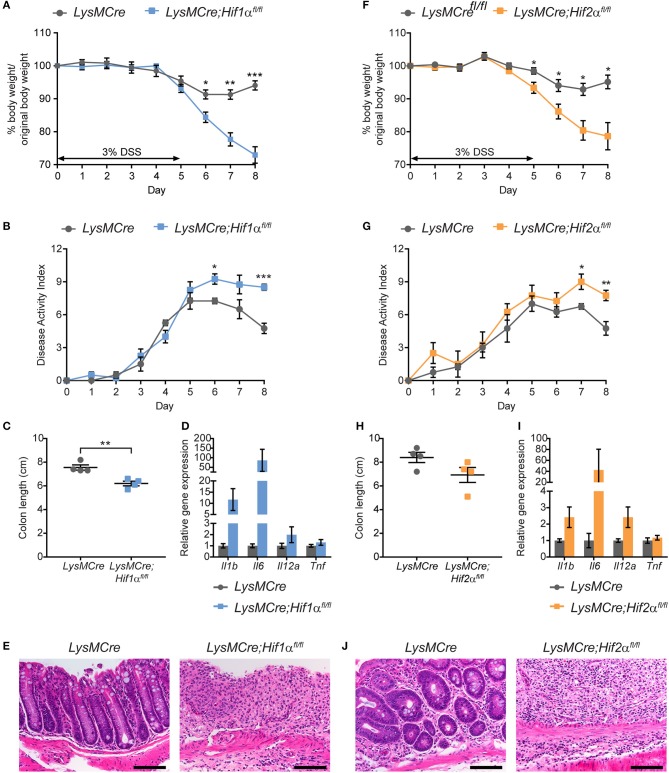
Myeloid HIF-1α and HIF-2α are required for proper resolution of DSS-induced acute colitis. Graphical summary of body weight changes (A,F), Disease Activity Index (B,G), colon lengths (C,H), expression of pro-inflammatory cytokine genes (D,I), and H&E images of colon about 1 cm from rectum (E,J) of LysMCre (n = 4; mean ± s.e.m.) and LysMCre;Hif1αfl/fl mice (n = 4; mean ± s.e.m.) or LysMCre;Hif2αfl/fl mice (n = 4; mean ± s.e.m.). All mice received 3% DSS in drinking water for 5 days, followed by 3 days on regular drinking water, and sacrificed on day 8. Analyses in (C–E,H–J) were performed using colonic tissues from mice sacrificed on Day 8. Student's t-test, *p < 0.05, **p < 0.01, and ***p < 0.001.